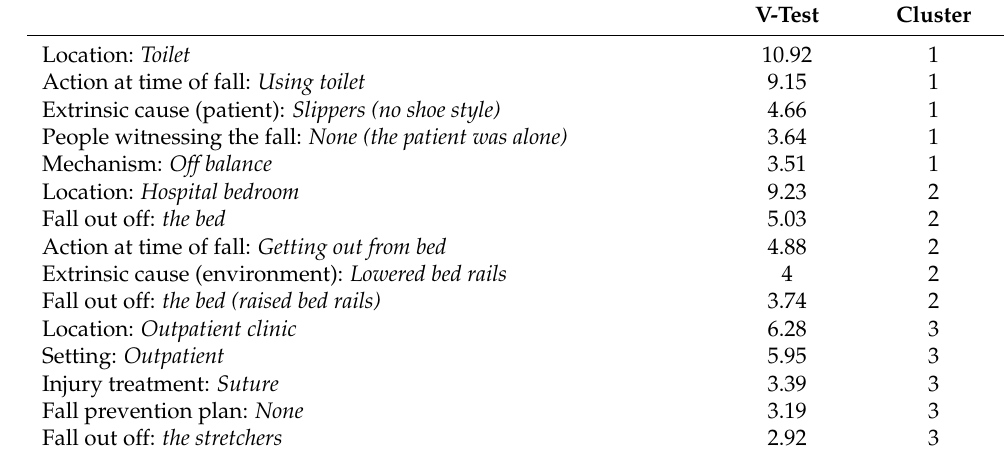
Table 4. Results of the HCPC analysis with topic variable. V-test represents the influence of vari- ables in the cluster composition. Cluster refers to the three distinct profiles of falls obtained from HCPC